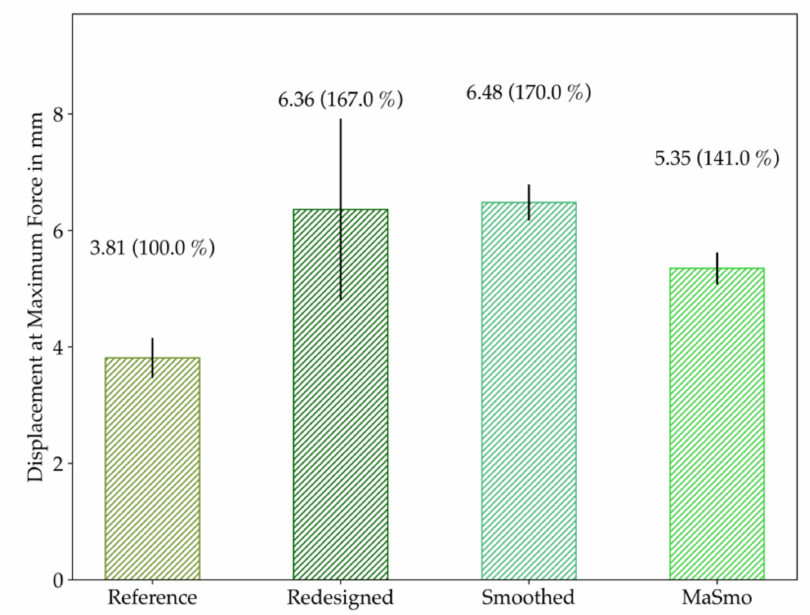
Figure 20. Comparison of the displacement at maximum force. The mean values are plotted together with the standard deviation. The difference from the reference is written in brackets in percent.